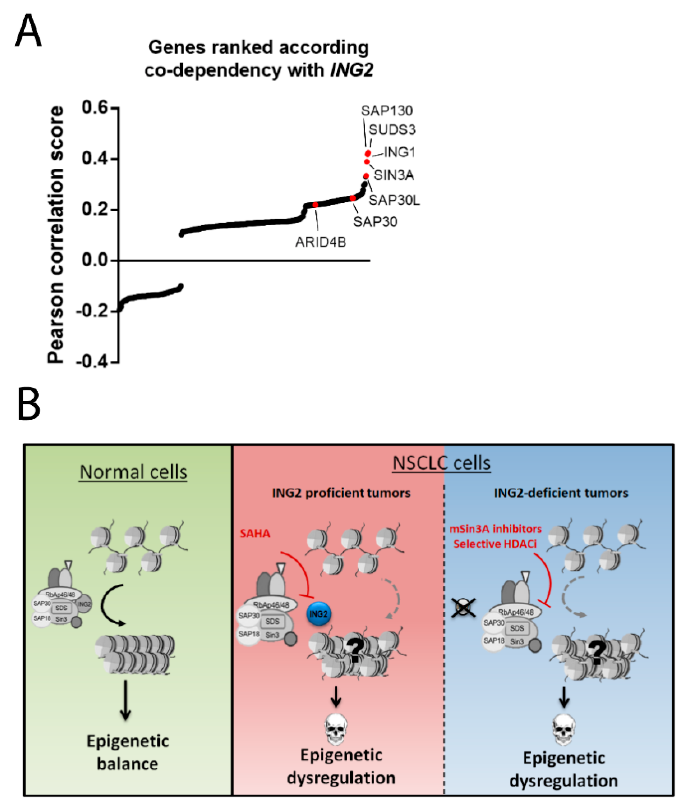
Figure 3. Co-dependency between ING2 and mSin3A / HDAC complex members in tumor cell lines. ( A ) Graph depicting ranked Pearson correlation score between the CERES dependency score for each tested gene in the Cancer Dependency Map Project and the ING2 CERES dependency score. ( B ) Working model for a ING2 biomarker-based therapeutic strategy in NSCLC. Tumors expressing ING2 are more likely to depend on the oncogenic properties of mSin3A / HDAC for survival and could be targeted by suberoyl anilide hydroxamic acid (SAHA). Tumors that lose ING2 expression cannot be treated by SAHA, but can be treated by mSin3A direct inhibitors (mSin3Ai) or HDAC1 / 2 inhibitors (s.HDACi).